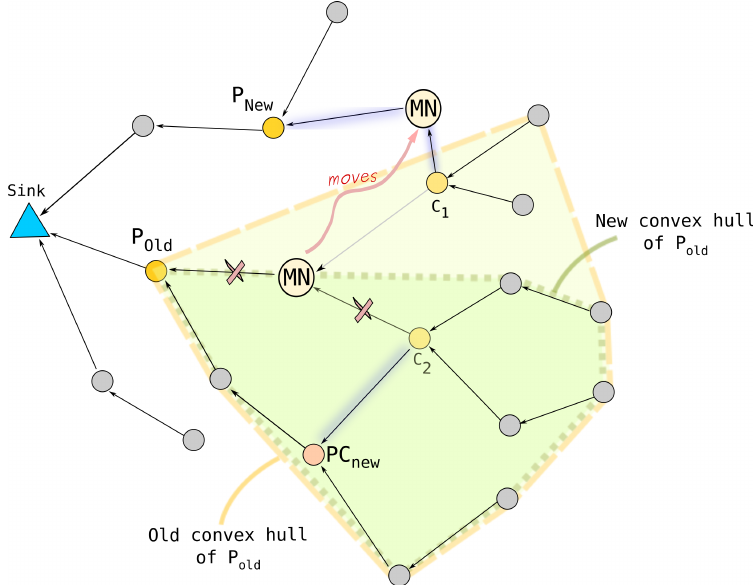
Figure 3. Effects of movement of MN on the routing tree and convex hulls.